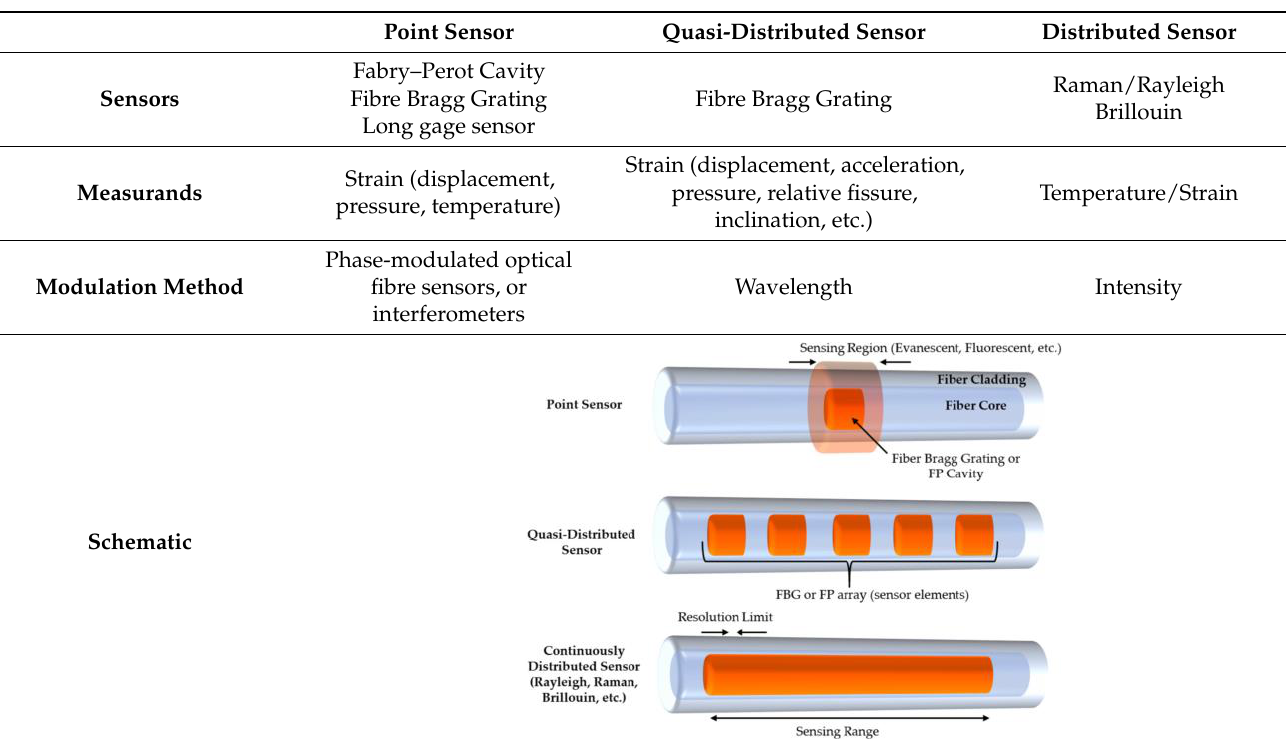
Table 1. Types of optic fibre sensors (adapted from